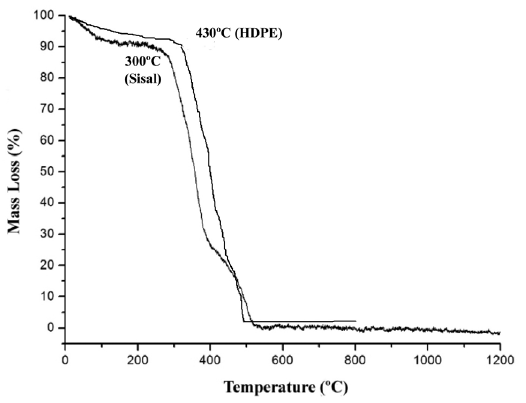
Figure 5. Sisal fiber